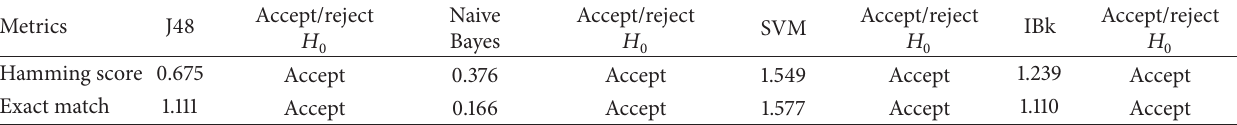
Table 8: Paired 𝑡 -test results of different evaluation metrics before and after applying MFSS for four classifiers.